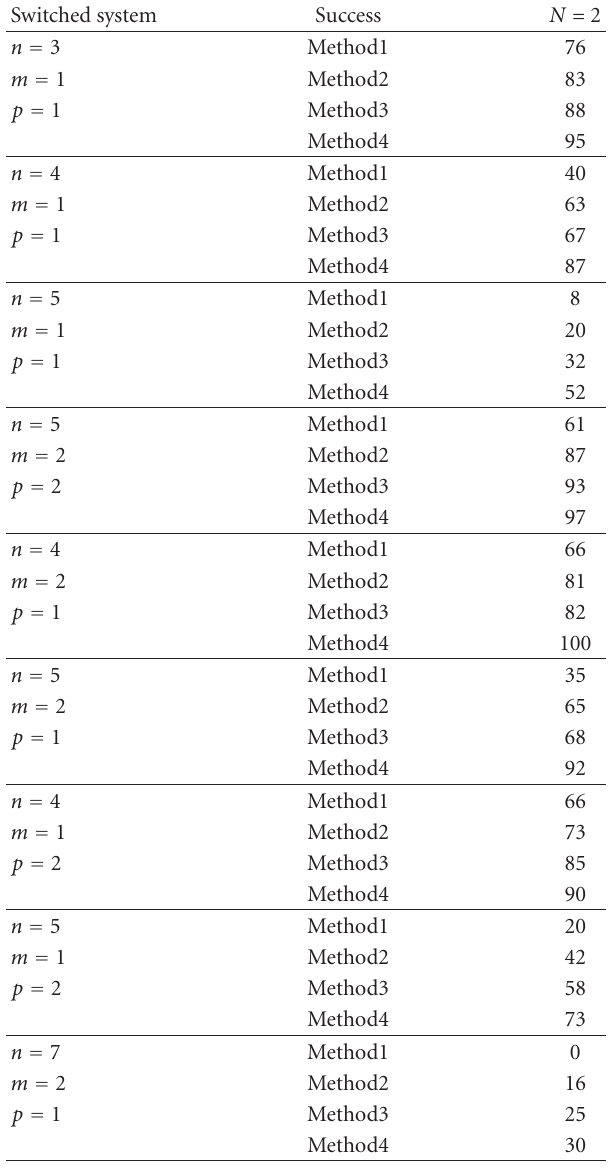
Table 1: Numerical